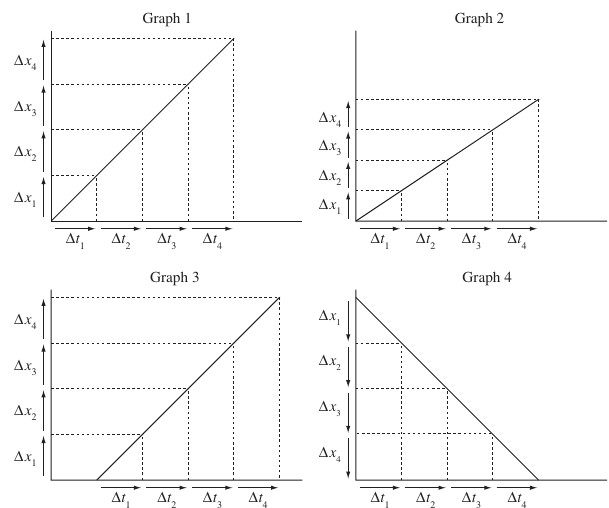
FIG. 2 (color online). Initial setup used in the uniform motion laboratory.